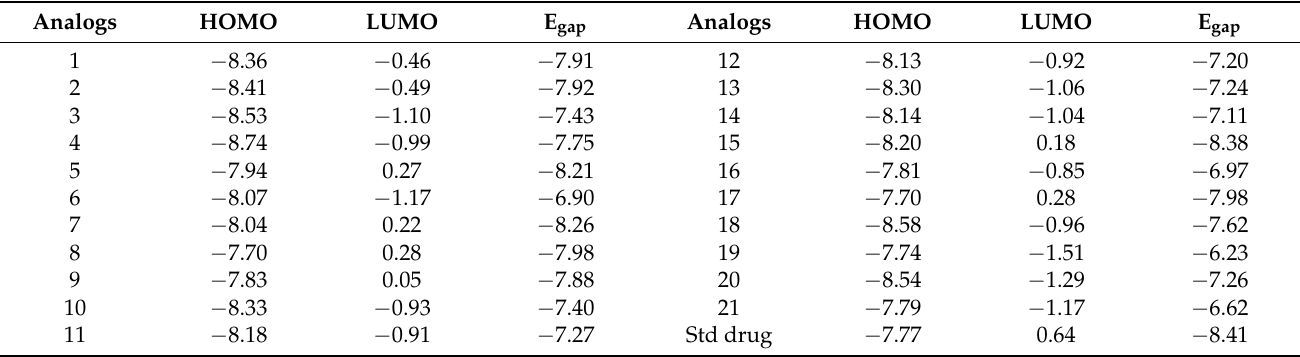
Table 3. HOMO, LUMO, and energy gap of studied thiazole-bearing sulfonamide analogs 1 – 21 and standard drug (all values are in